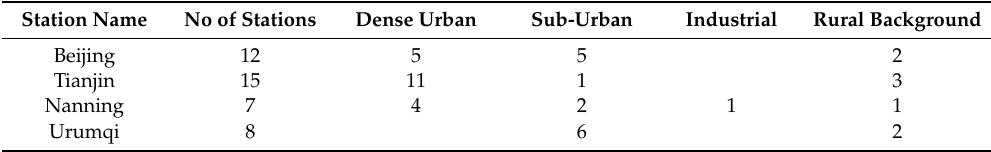
Table 1. Details of surface air quality monitoring